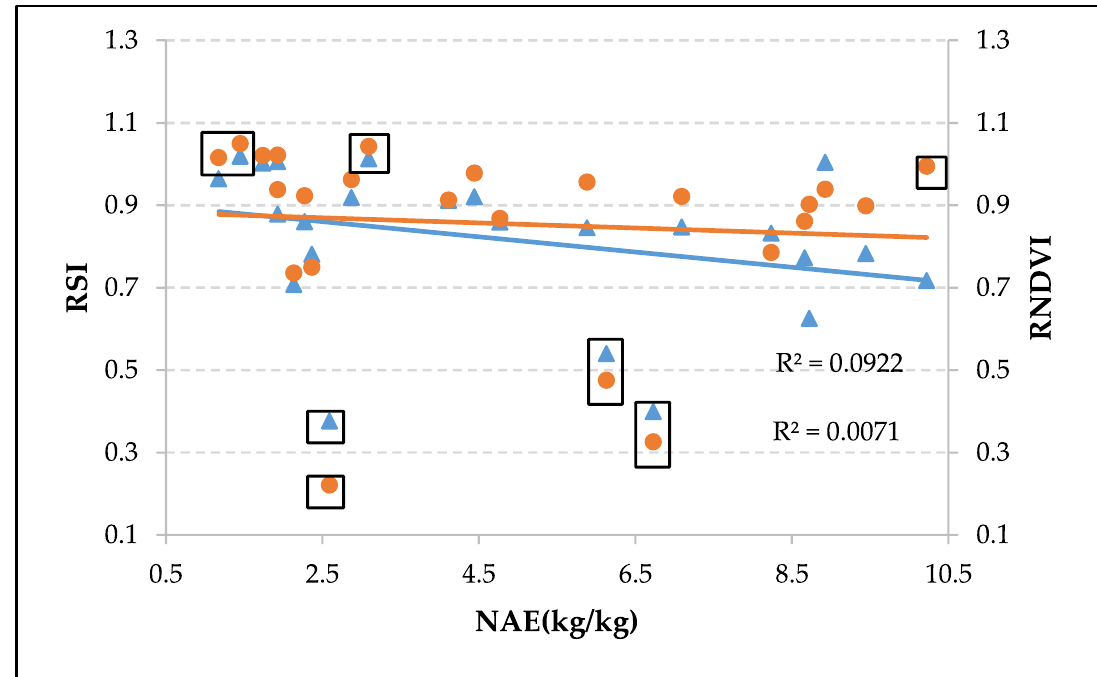
Figure 5. The relationship of relative SPAD index (RSI) and relative normalized difference vegetation index (RNDVI) with nitrogen agronomic efficiency (NAE) of 12 wheat varieties cultivated under three N levels. The points marked with a square box show deviation of the varieties from the regression trend line.